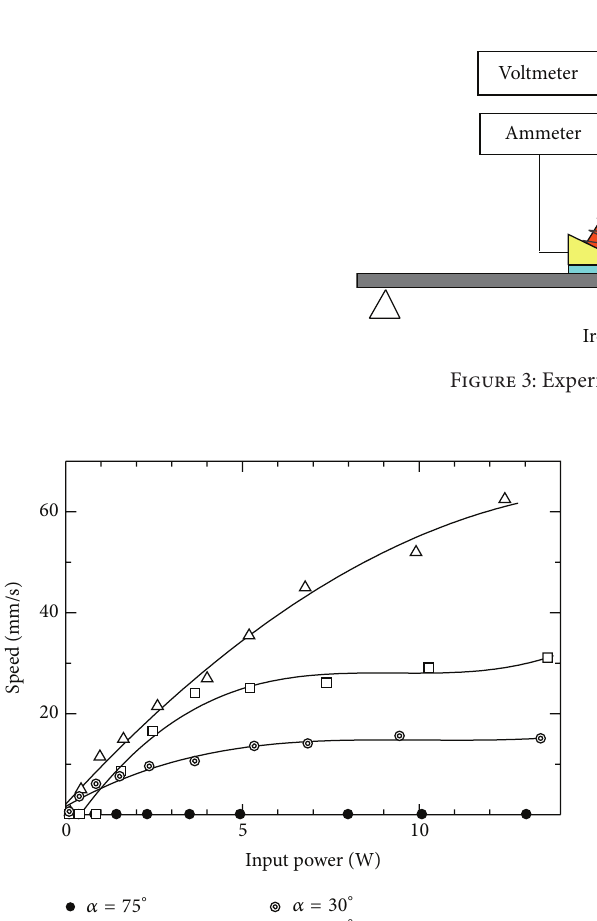
Figure 2: Principle of locomotion.